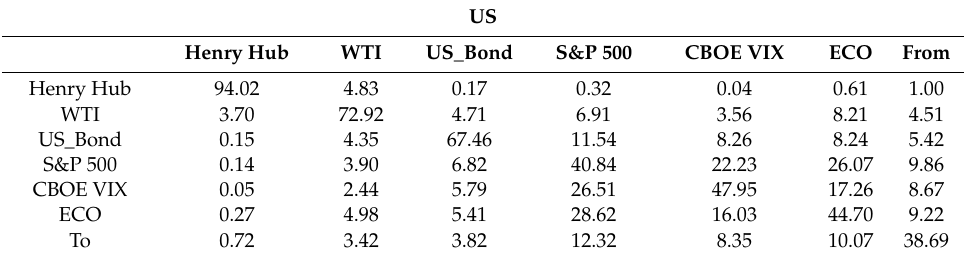
Table A3. Return spillover results (US).